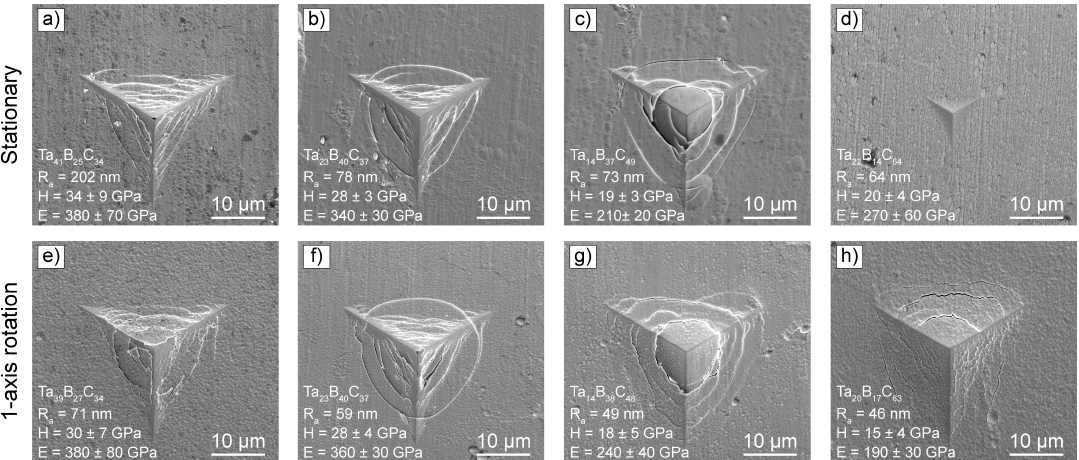
Figure 15. Residual indenter impressions after 1N indentation of coatings with corresponding composition, average roughness, hardness and elastic modulus ( a – d ) stationary sample; ( e – h ) sample carrying out 1-axis